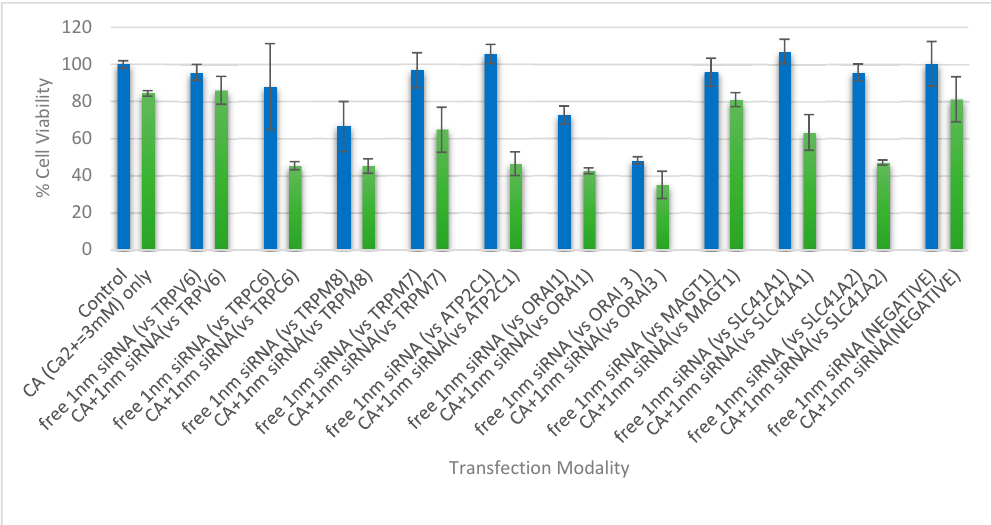
Figure 8. Cell viability assessment of 4T1 cells treated with NP-siRNA complex and unbound siRNA, where the NP is CA formed with 4.0 mM exogenous CaCl 2 . The cells were treated with media (negative control) or NPs formed with 4.0 mM of exogenous CaCl 2 (CA only), and were compared with different siRNA against cation channels and transporter proteins, of 1 nM concentration, both free and bound to the inorganic NP. After 44 h of treatment, cell viability was measured by MTT assay. Values are represented as the mean % of cell viability ± SEM, when compared to untreated cells, where N = 3.